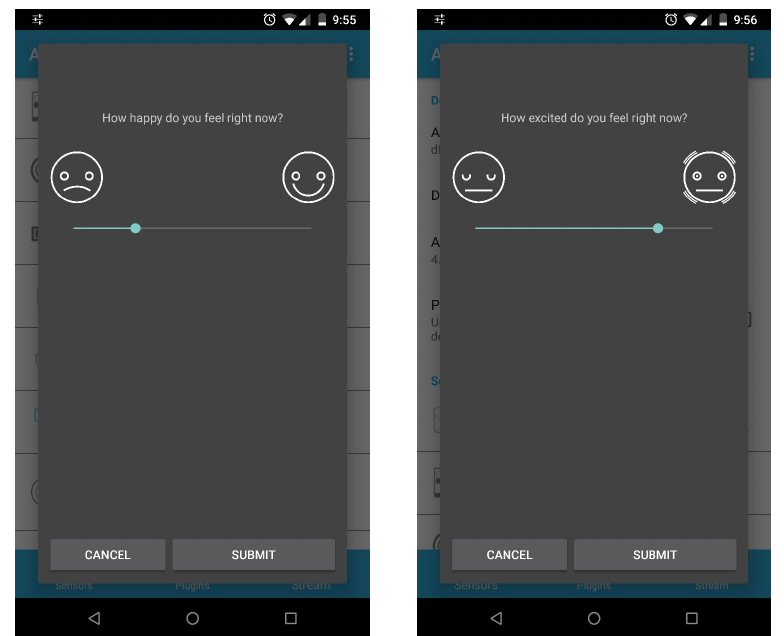
Figure 4. Screenshots of the ESM questions for assessing valence and